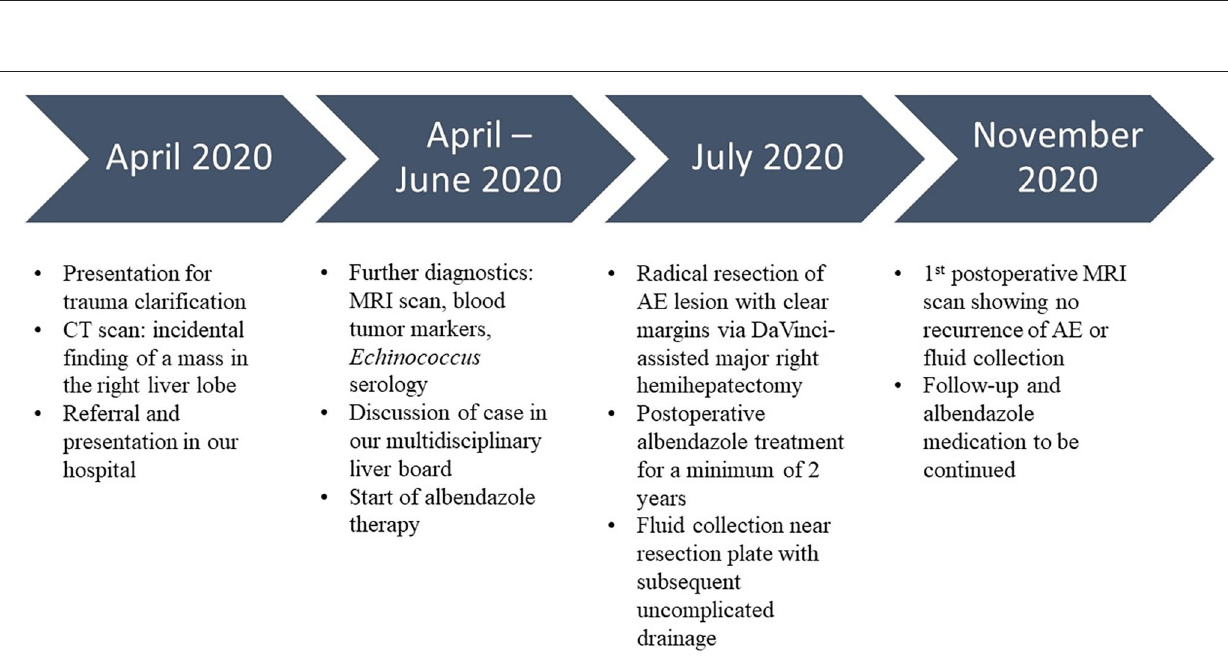
FIGURE 3 | Timeline of the presented